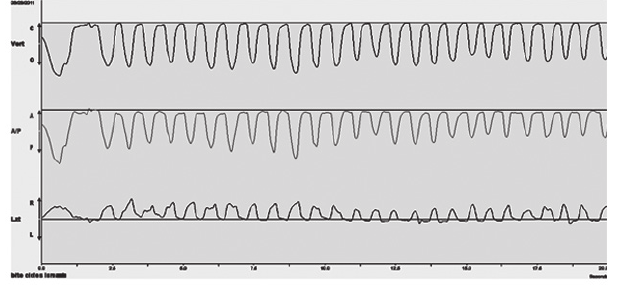
Figure 1 Vert, total count of the number of cycles. Lat, number of masticatory cycles to the right and left, and A/P, number of protrusions and